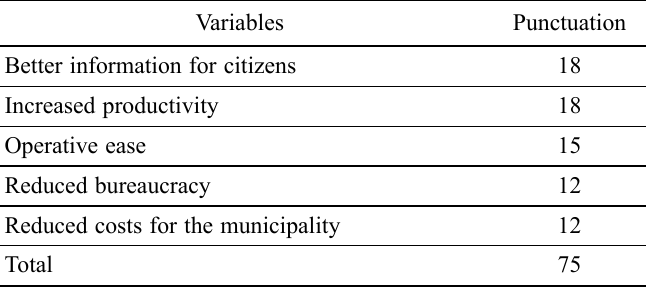
Table 5. Main results obtained with the use of ICT in